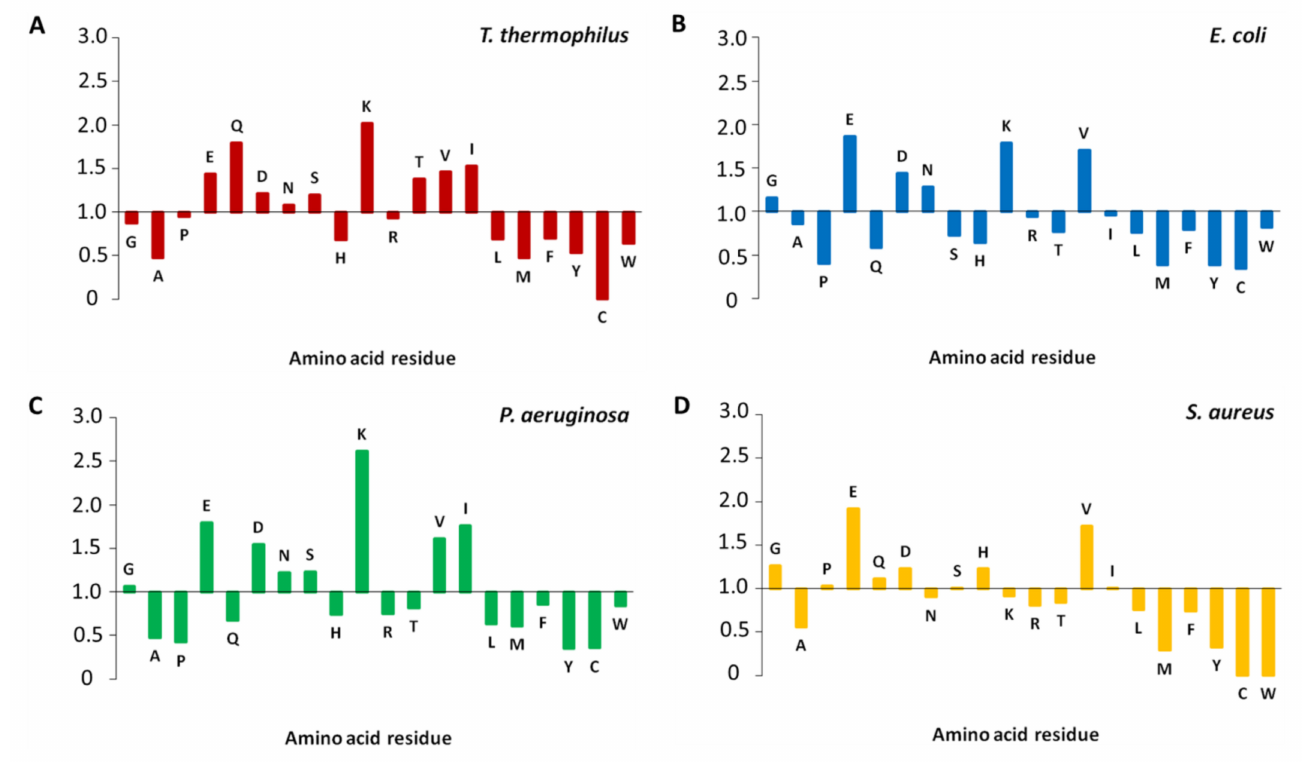
Figure 4. Comparison of the amino acid composition of the structures of S1 proteins from T. thermophilus ( A ), E. coli ( B ), P. aeruginosa ( C ), and S. aureus ( D ) with the corresponding bacte- rial proteome